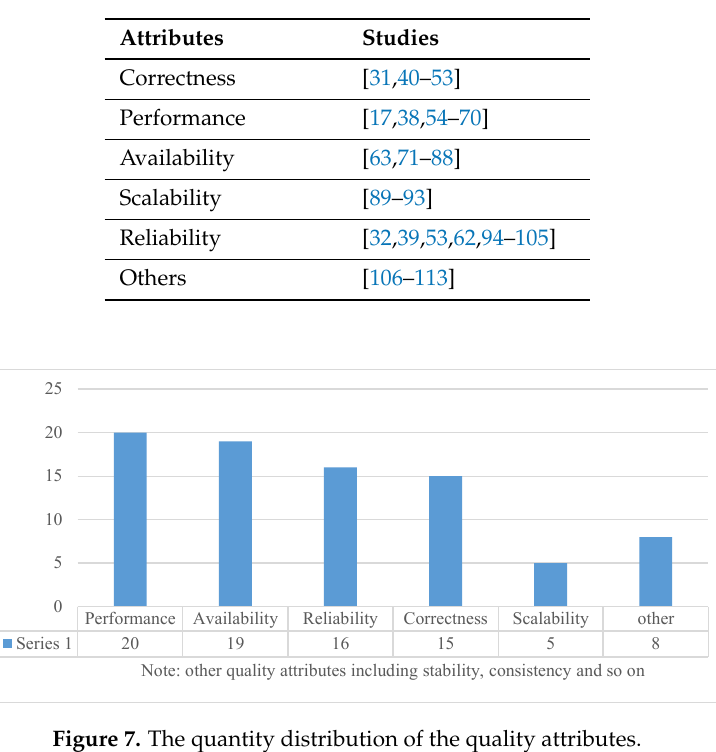
Table 8. Distribution of the quality attributes.